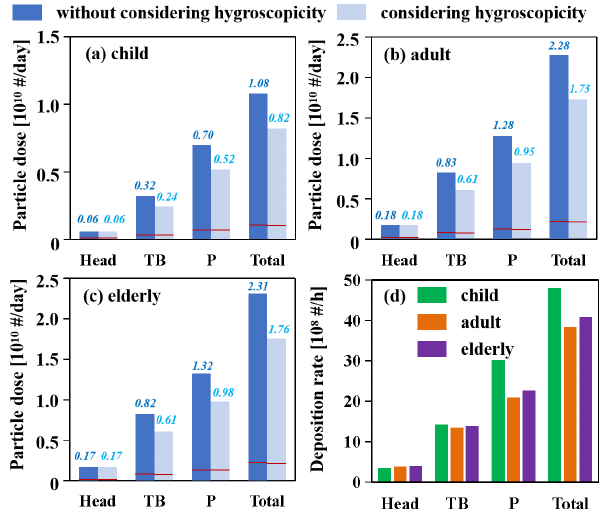
Figure 3. Regional and total deposition doses for (a) children, (b) adults, and (c) the elderly with/without considering particle hygro- scopicity. The dark blue columns represent doses without consid- ering hygroscopicity. The light blue columns represent doses con- sidering hygroscopicity. The red lines on the column represent the division of doses of hygroscopic (above the red line) and hydropho- bic particles (below the red line). Numbers above each column mean the corresponding particle doses with a unit of 10 10 particlesd − 1 . (d) The average regional and total deposition rates considering hy- groscopicity for three age groups. The green, orange, and purple columns represent children, adults, and the elderly,